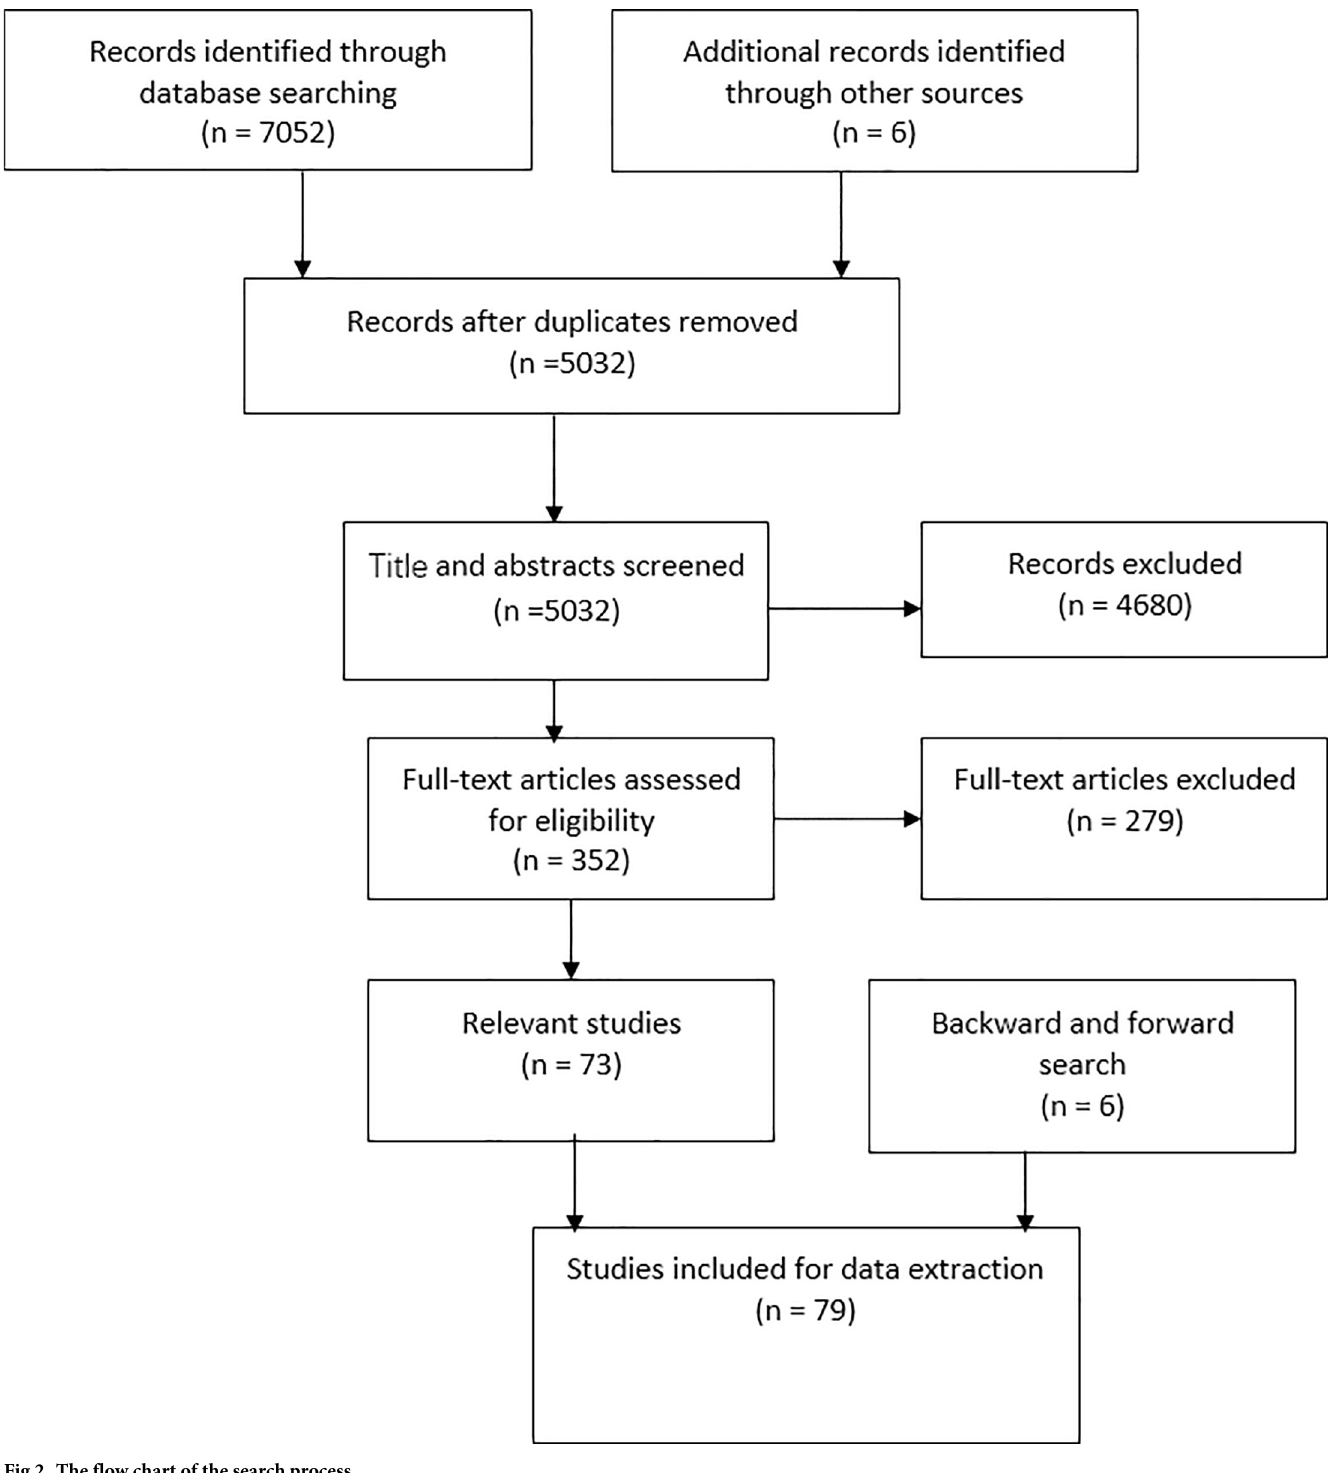
Fig 2. The flow chart of the search process.